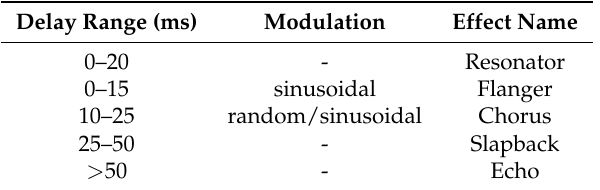
Table 1. Delay time range approximates for delay-based effects according to Dutilleux [80]: The modulation sources may vary depending on the implementation and musical